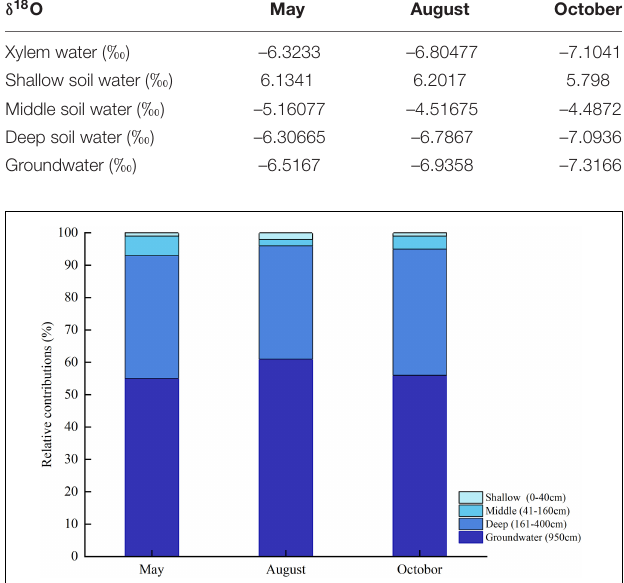
FIGURE 8 | Water uptake from shallow, middle, and deep soil layers and from groundwater for T. ramosissima during the 2020 growing season.